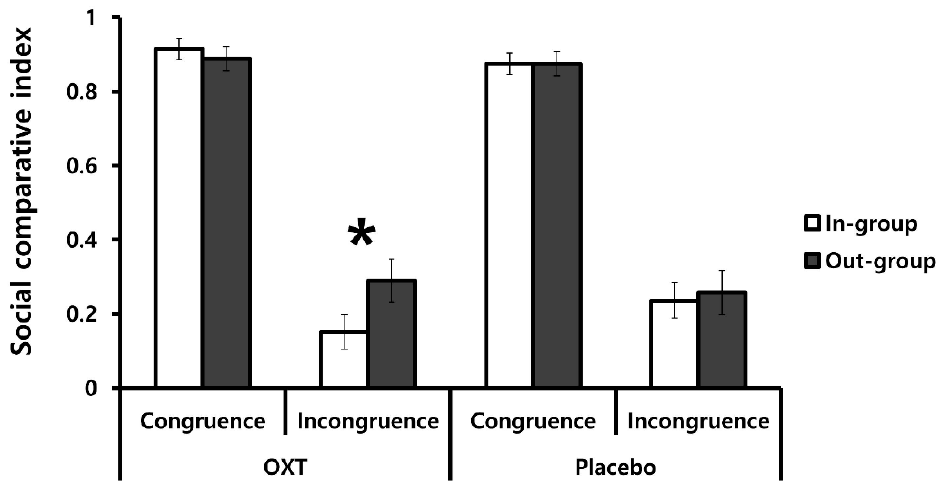
Table 1. Mean (SD) social comparative indices for each condition.